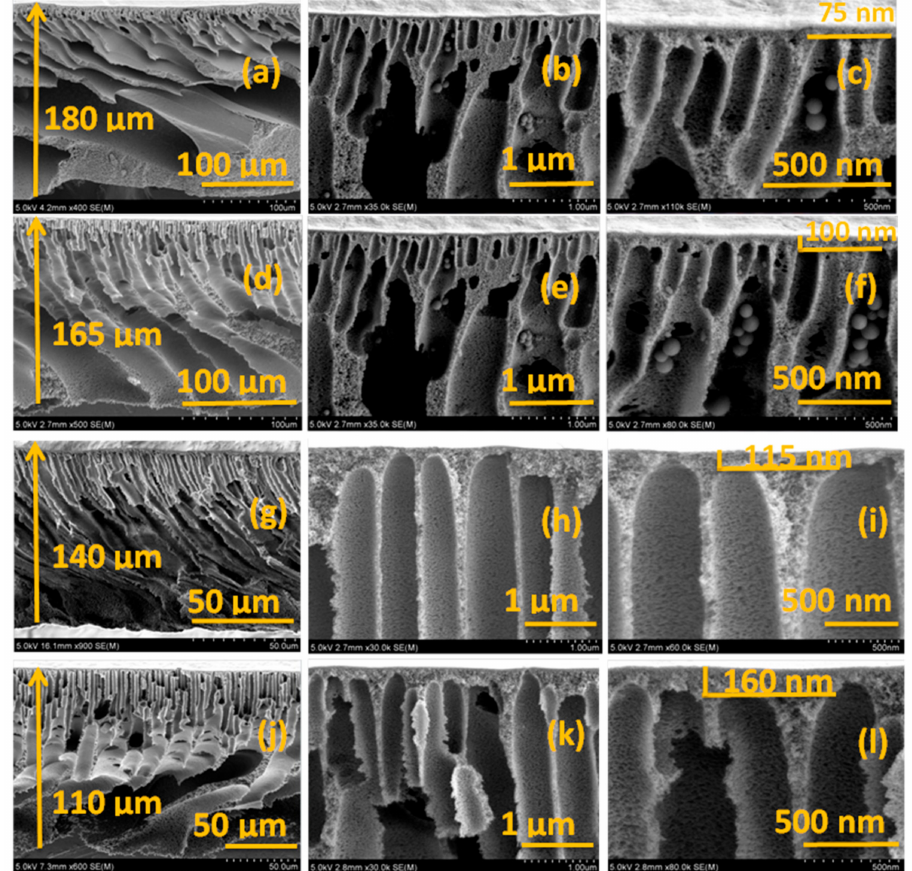
Figure 6. The cross-sectional SEM images of pristine PES and TiO 2 NTs / PES nanocomposite membranes ( a – c ); pristine PES membrane ( d – f ); 0.25% TiO 2 / PES membrane ( g – i ); 0.5% TiO 2 / PES membrane; and ( j – l ) 1% TiO 2 / PES